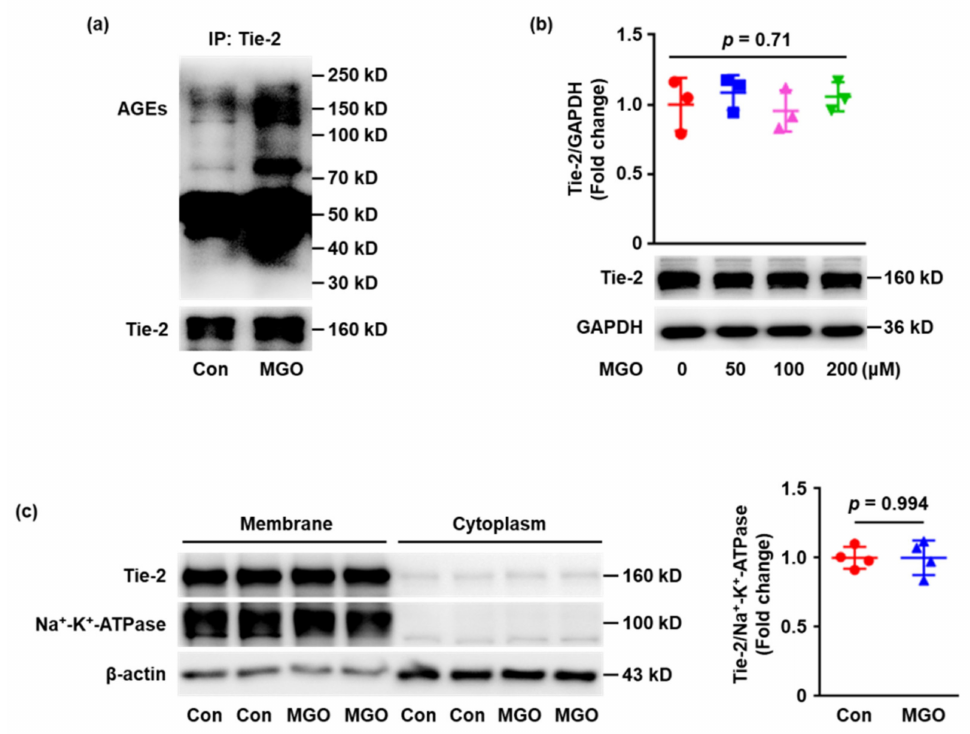
Figure 2. Tie-2 is glycated in MGO–treated endothelial cells. ( a ) HUVECs were exposed to MGO (100 µ M) or vehicle control for 24 h. The cell lysates were immunoprecipitated with anti-Tie-2 antibody and the captured proteins were analyzed by Western blotting with anti-AGE and anti-Tie2 antibodies. Representative images of three independent experiments are shown. ( b ) HUVECs were stimulated with MGO (0, 50, 100 and 200 µ M) for 24 h and total expression of Tie-2 was detected using Western blotting. Representative images of three independent experiments are shown and densitometric analysis of Tie-2 normalized to GAPDH was performed. ( c ) HUVECs were stimulated with MGO (100 µ M) or vehicle for 24 h and the cell membrane proteins were separated. The Tie-2 expression at the cell membrane was determined with Western blotting and representative images of three independent experiments are shown. The densitometric analysis of Tie-2 normalized to Na + -K + -ATPase was carried out. Error bar represents the standard deviation and p value was generated by t